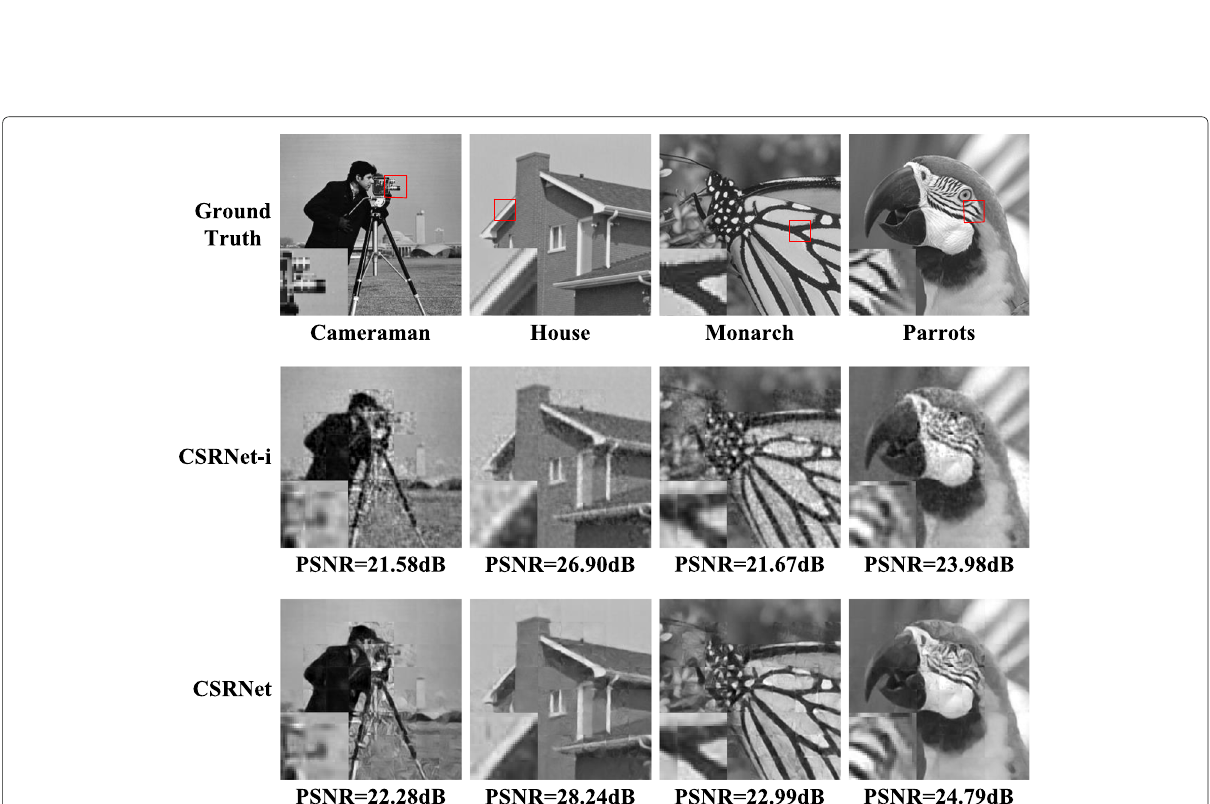
Fig. 18 The intermediate and final reconstruction results of CSRNet at the measurement rate